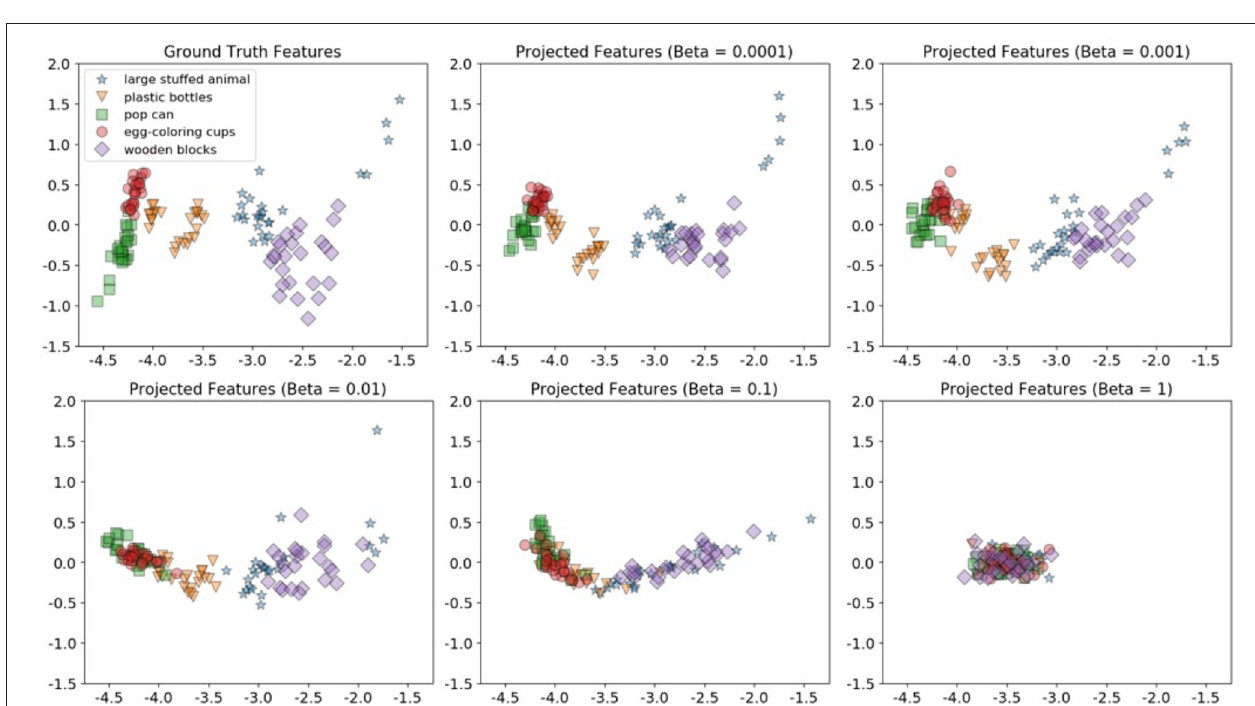
FIGURE 14 | 2D visualizations using Principal Component Analysis of the target robot’s hold-haptic ground truth features (top-left) and five β -VED projected features’ (from shake-haptic ) clusters for different β values (in increasing order from top to bottom and left to right).